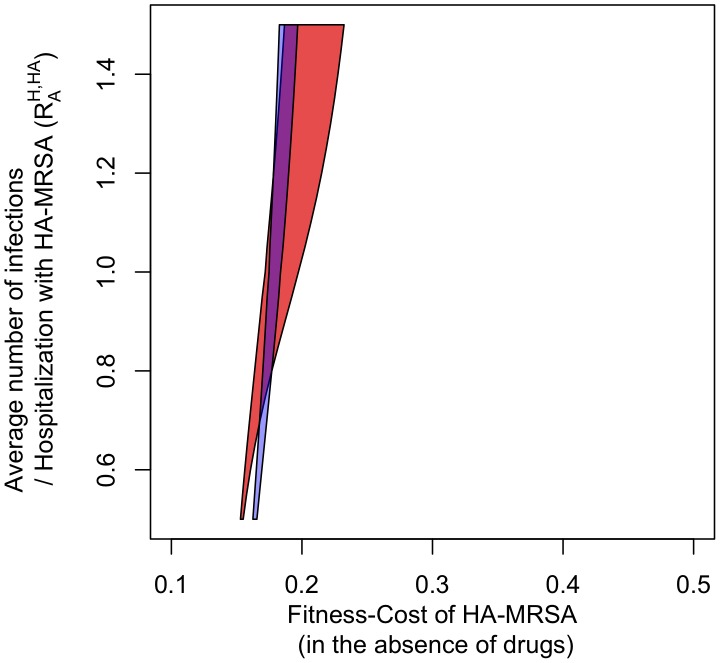
The blue area indicates the parameter combinations for which HA-MRSA and CA-MRSA coexist in the basic model.The red area indicates co-existence in the age-structured model. Axes and parameter values are the same as in Figure 3. Note that in order to assure comparable transmissibility measures as y-axes in the homogeneous and heterogeneous models, we measure transmissibility as the single-admission reproductive number R0HA,H – i.e. the dominant eigenvalue of the next-generation matrix of the hospital [41], [42] (see Table 1).